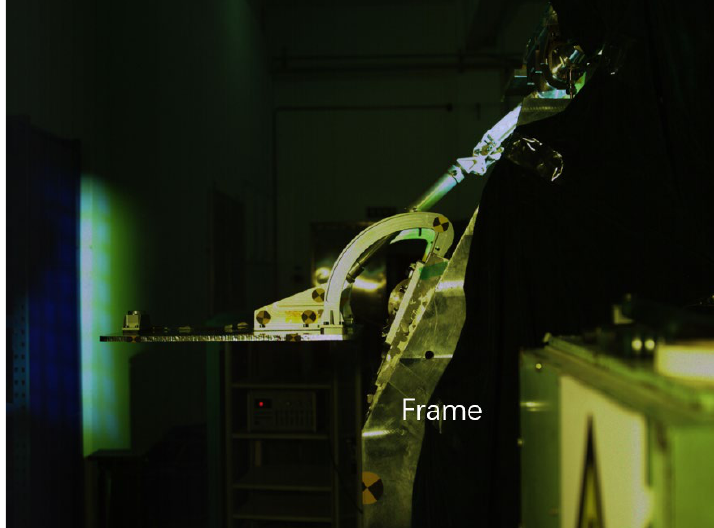
Figure 7. Physical prototype of the trim flap system.